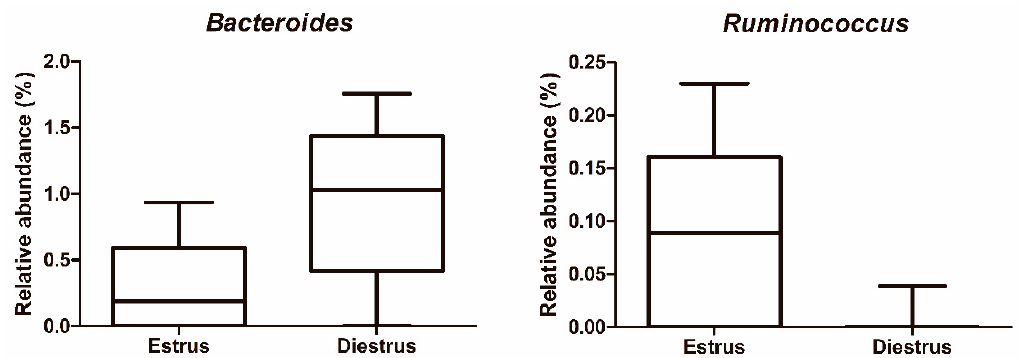
Figure5. Di ff erencesinrelativeabundanceofunidentifiedspeciesofgenera Bacteroides and Ruminococcus Figure 5. Differences in relative abundance of unidentified species of genera Bacteroides and between estrus and diestrus in vaginal mare Ruminococcus between estrus and diestrus in vaginal mare samples.